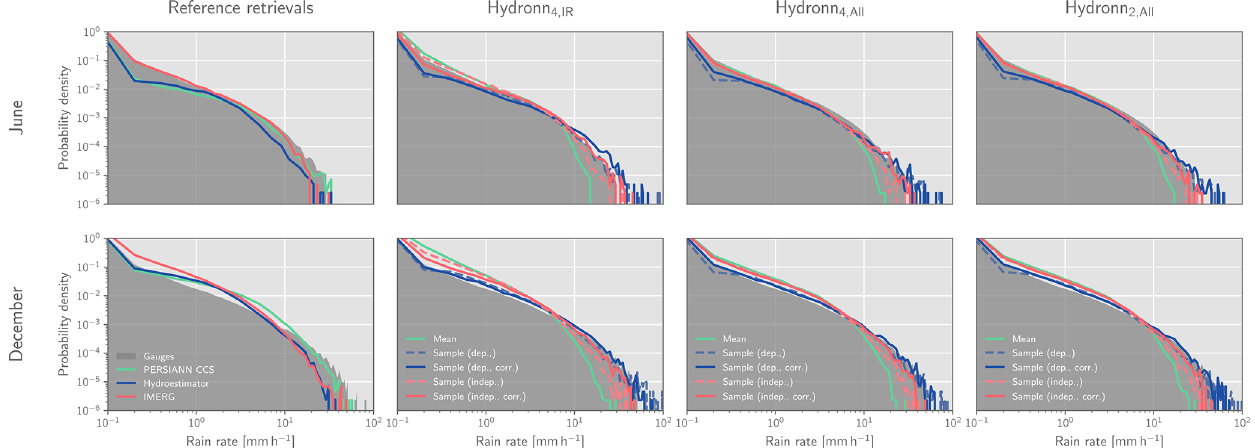
Figure 14. Distributions of measured and retrieved rain rates. The filled dark-grey curve in the background of each panel shows the PDF of the gauge measurements. Colored lines drawn on top show the corresponding PDFs of the retrieved precipitation. The distributions for the reference algorithms are shown in panel (a) . Panels (b) , (c) , and (d) show the distribution of mean values and random samples from the retrieval